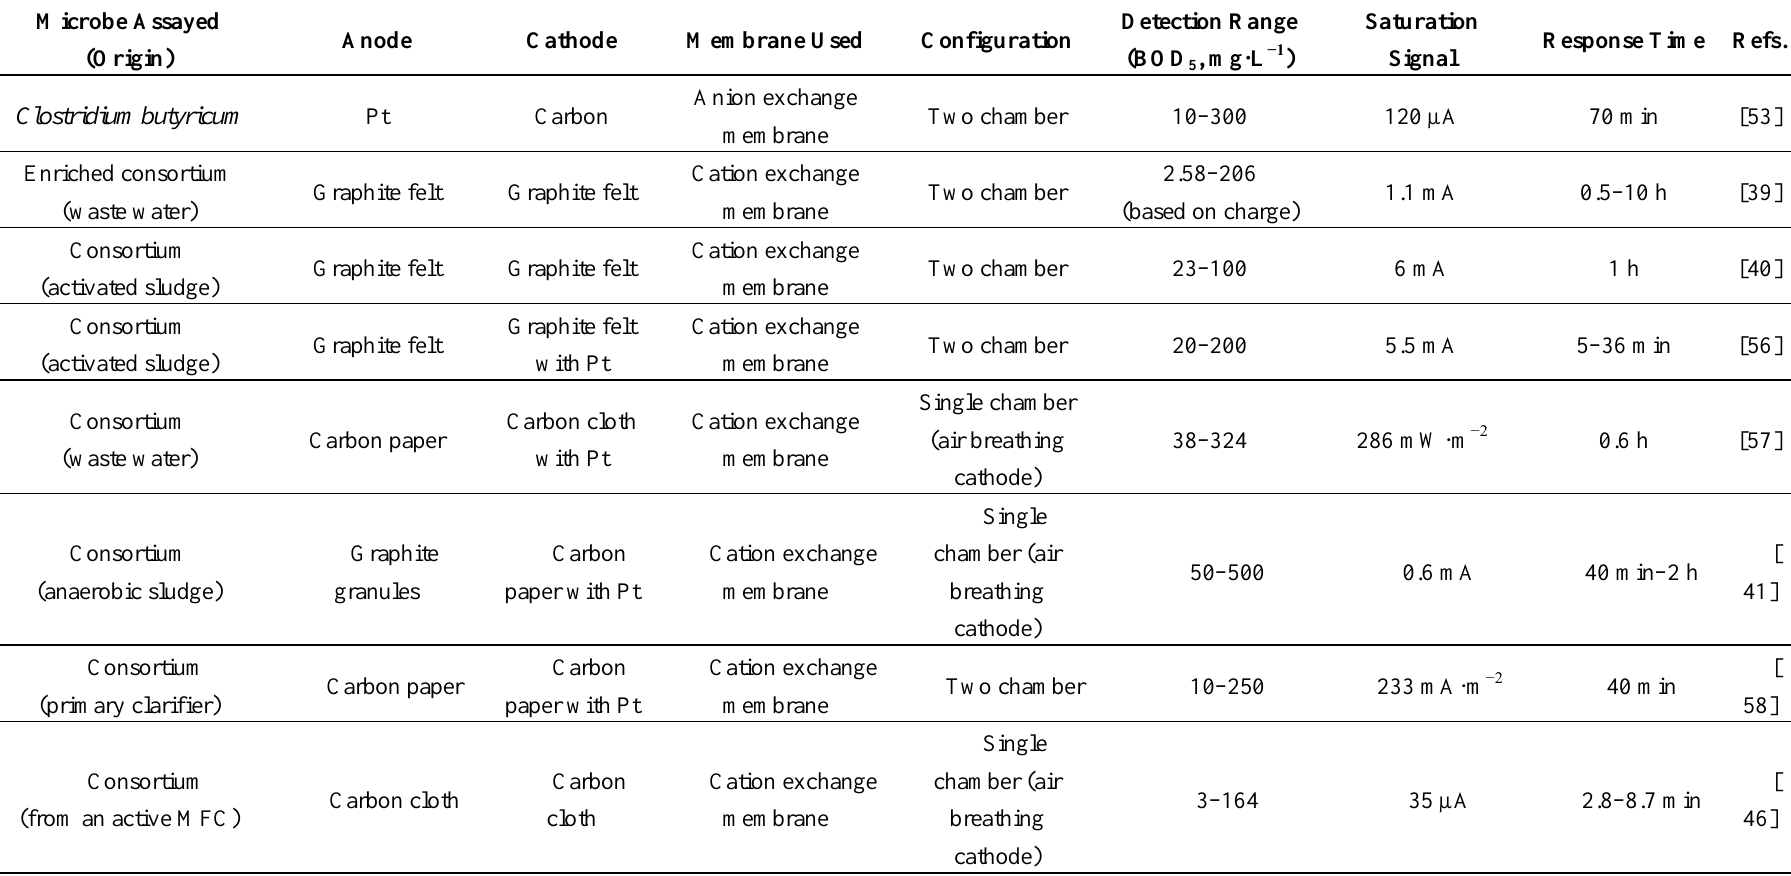
Table 2. Summary of analytical performance, construction and functional characteristics of MFCs used as